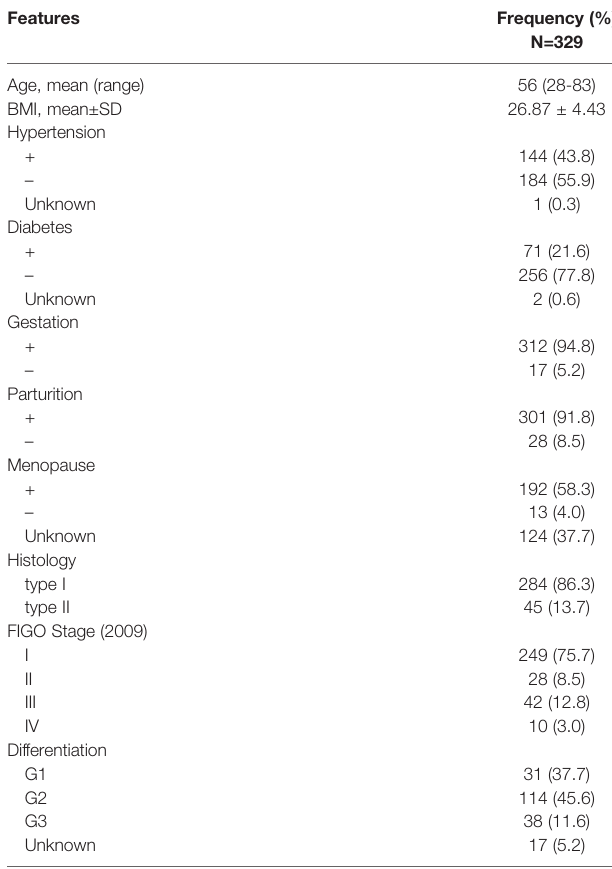
TABLE 1 | Clinicopathological data of patients with endometrial